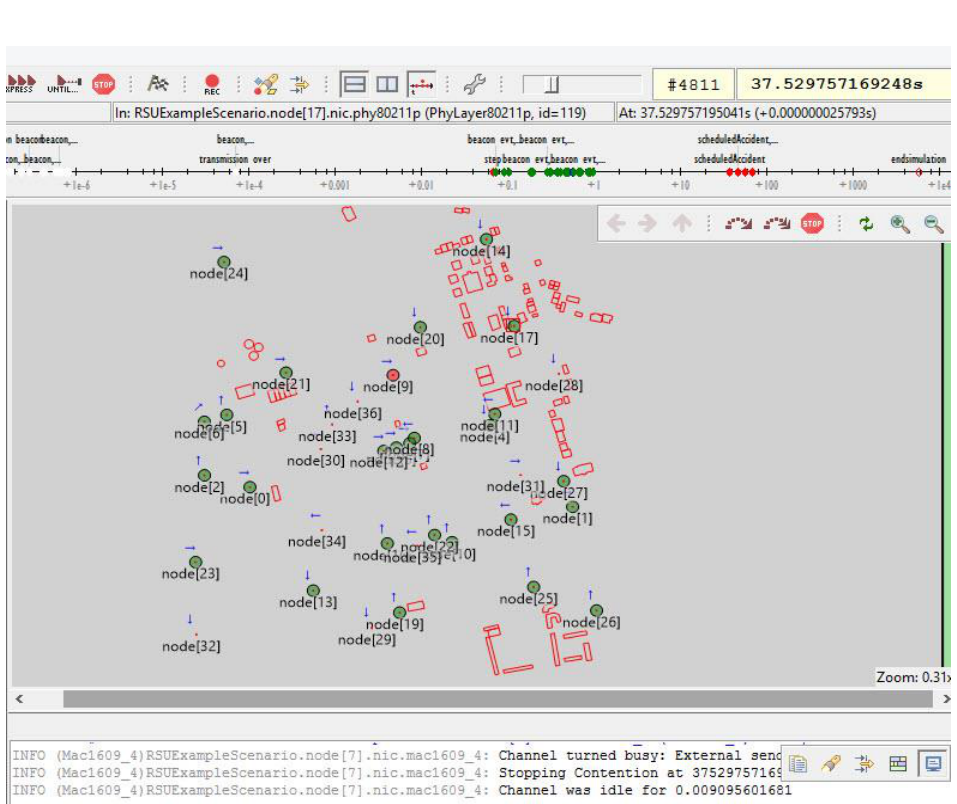
Figure 6. Simulation visualization on Omnet++ IDE.